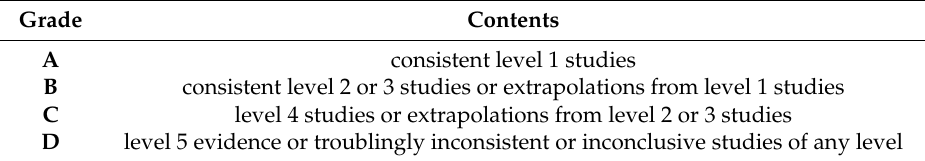
Table 3. Grades of Recommendation (Oxford Centre for Evidence-based Medicine—March 2009)